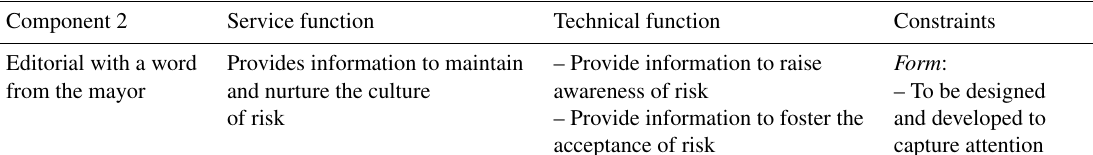
Table 7. Functional analysis table for Component 2.